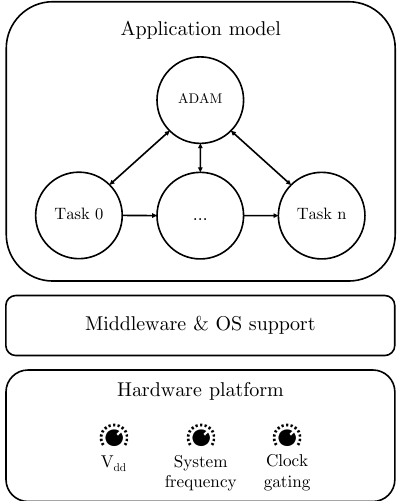
Figure 2. IoMT node architecture